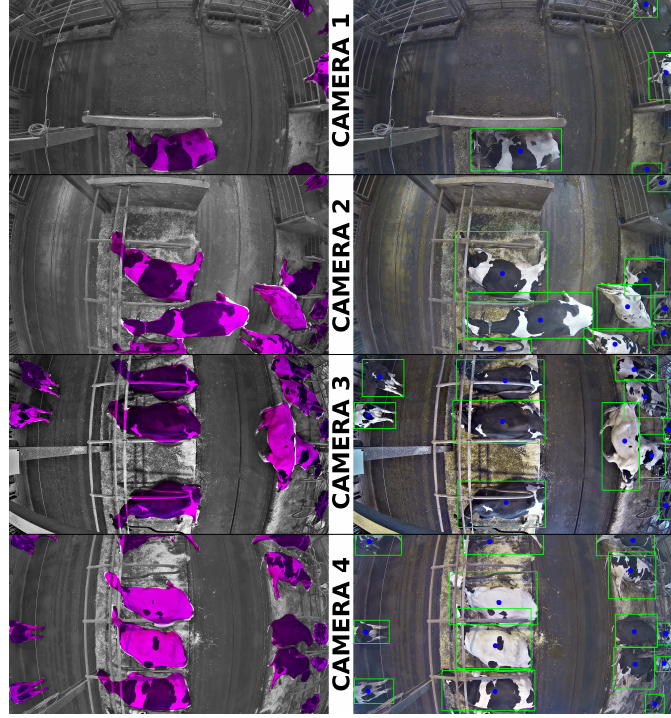
Figure 5. Examples of the resulting cow detection on unseen data for cameras 1 to 4. On the left, the masks are visualized. On the right, the bounding boxes are displayed. The centroids of the masks are marked blue.